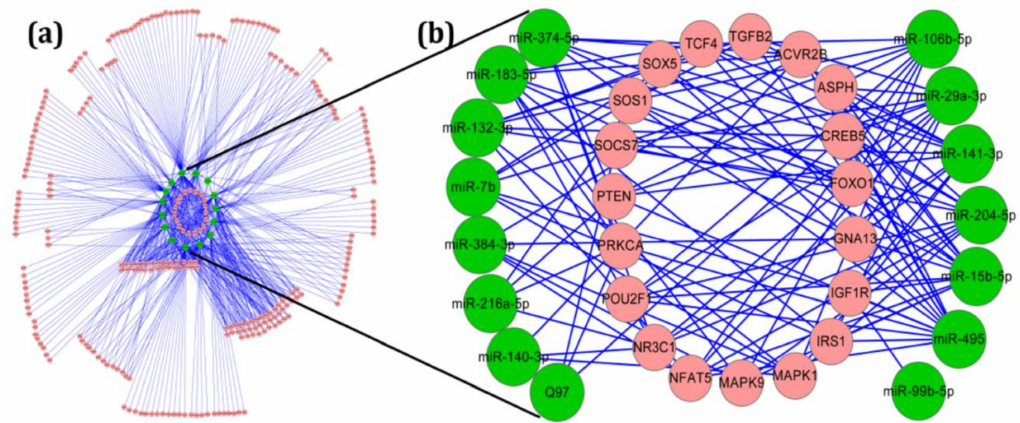
Figure 3. A network of miRNAs and their predicted targets participate in the pathways involved in pituitary function. ( a ) All of the miRNA–gene interaction bipartite networks participate in the pathways involved in pituitary function. ( b ) miRNA–gene bipartite network interactions that represent potential target genes with five or more focus miRNAs. The green ellipses indicate miRNAs, and the red ellipse indicates the predicted